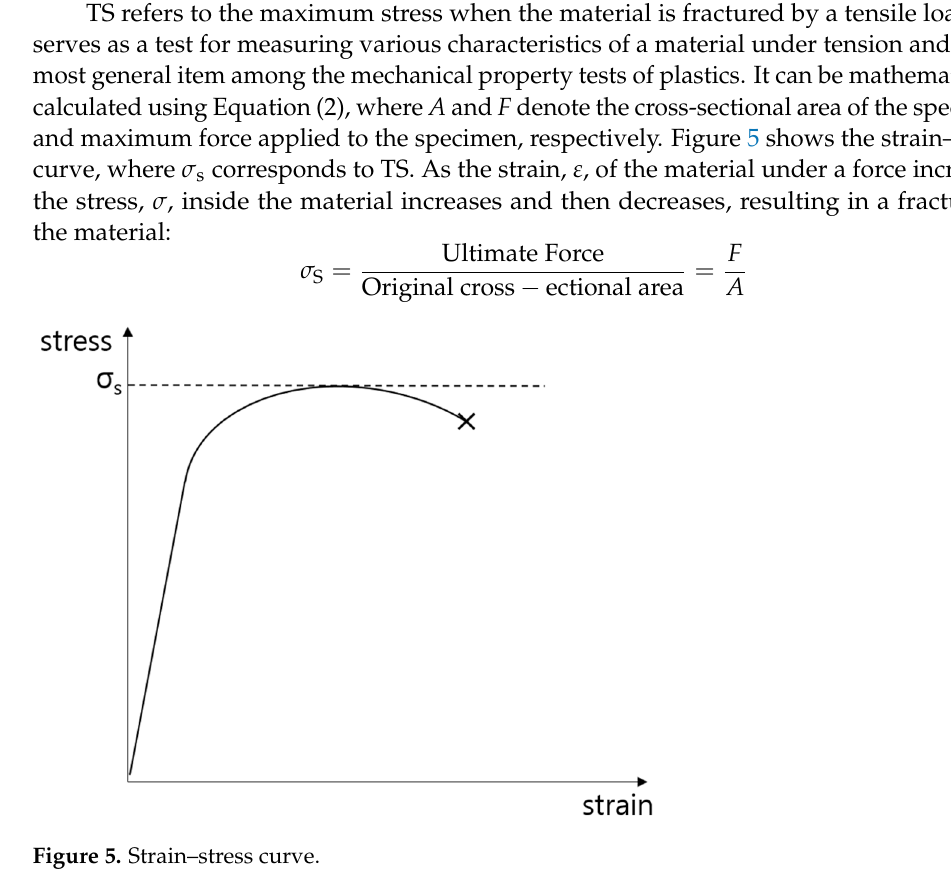
Figure 4. Experimental setup for measuring the MI.